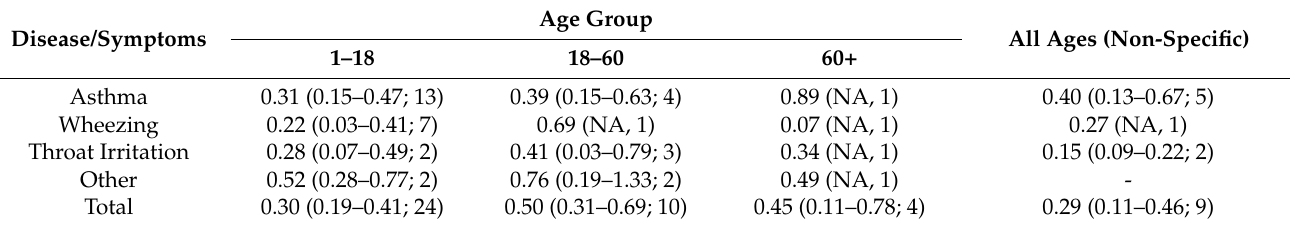
Figure 2. Effect size distribution by disease/symptom types ( A ) and air pollution types ( B ). Table 4. Disease/symptom specific effects size by age groups.